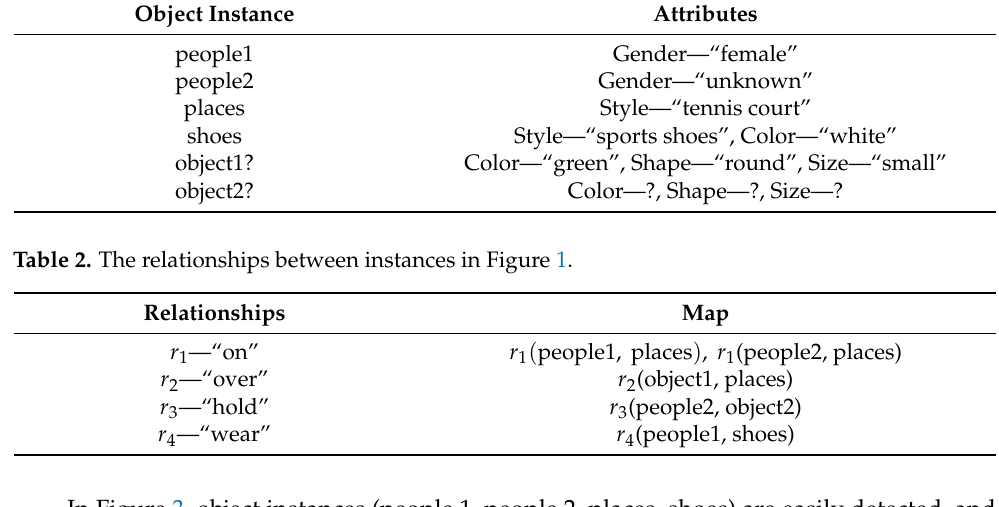
Table 1. The object instances and their attributes in Figure 1.